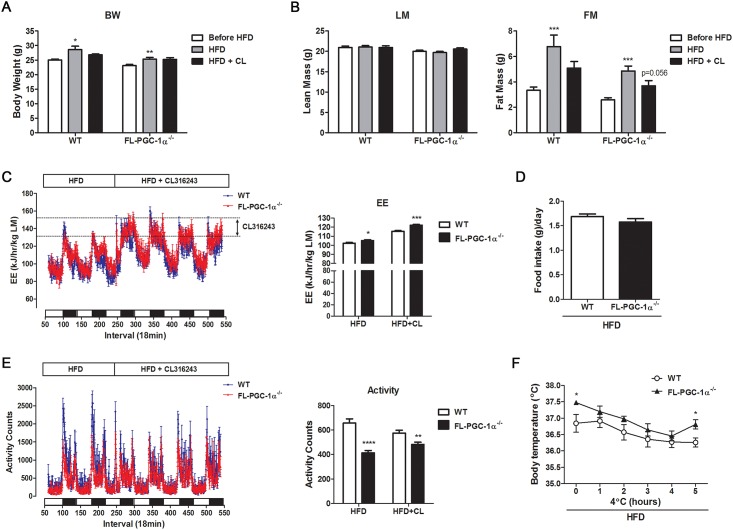
An increase in adipose tissue-driven thermogenesis in FL-PGC-1α-/- mice attenuates adipose tissue expansion under the HFD.(A, B) Body weight and composition of WT and FL-PGC-1α-/- mice. Mice were measured for body weight and composition prior to introduction of HFD, after 2 weeks on HFD and after additional 6 days on CL 316243+HFD. BW: body weight, LM: lean mass, FM: fat mass (C) Energy expenditure (EE) of WT and FL-PGC-1α-/- mice. Mice were measured for VO2 and VCO2 on HFD for first two days and on HFD + CL316243 for additional four days. EE (kilojoules per hour) was calculated as described in Materials and Methods and expressed per lean mass (LM). (D) Average food intake of WT and FL-PGC-1α-/- mice on HFD. Food intake was expressed as grams per day per mouse. (E) Voluntary activity of WT and FL-PGC-1α-/- mice. Ambulatory activity was monitored at 18 min intervals for 6 days on HFD and HFD + CL316243. (F) Core body temperature of WT and FL-PGC-1α-/- mice (n = 7–9 per group). Mice fed a HFD for 3 weeks were exposed to 4°C and their core body temperature was measured for 5h using a MicroTherma thermometer with the RET-3 mouse rectal probe. *P < 0.05, **P < 0.01, ***P < 0.001, ****P < 0.0001.